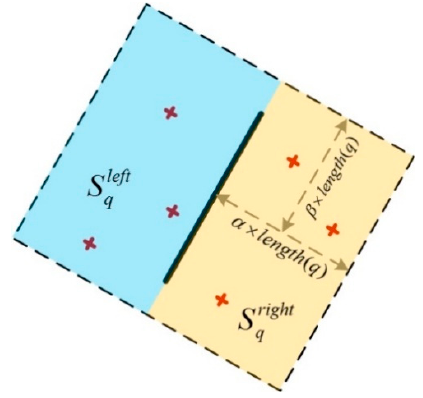
Figure 5. Search region determination. Sensors 2019 , 19 , 1086